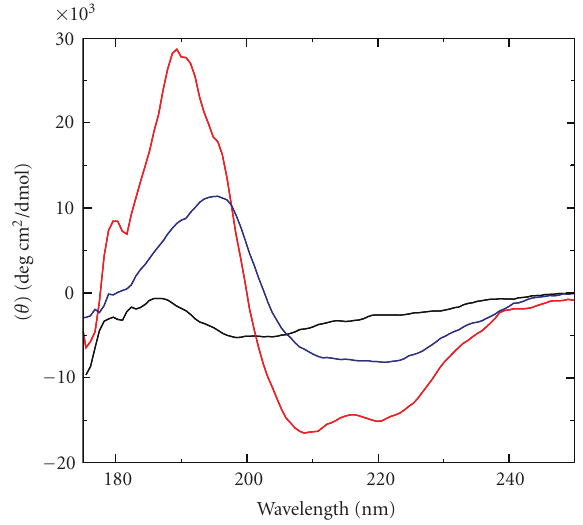
Figure 2: VUVCD spectra of 0.2mM A β (1–40) in the absence or presence of GM1. A β /GM1 molar ratios were 1: 0 (black), 1:15 (blue), and 1 :30